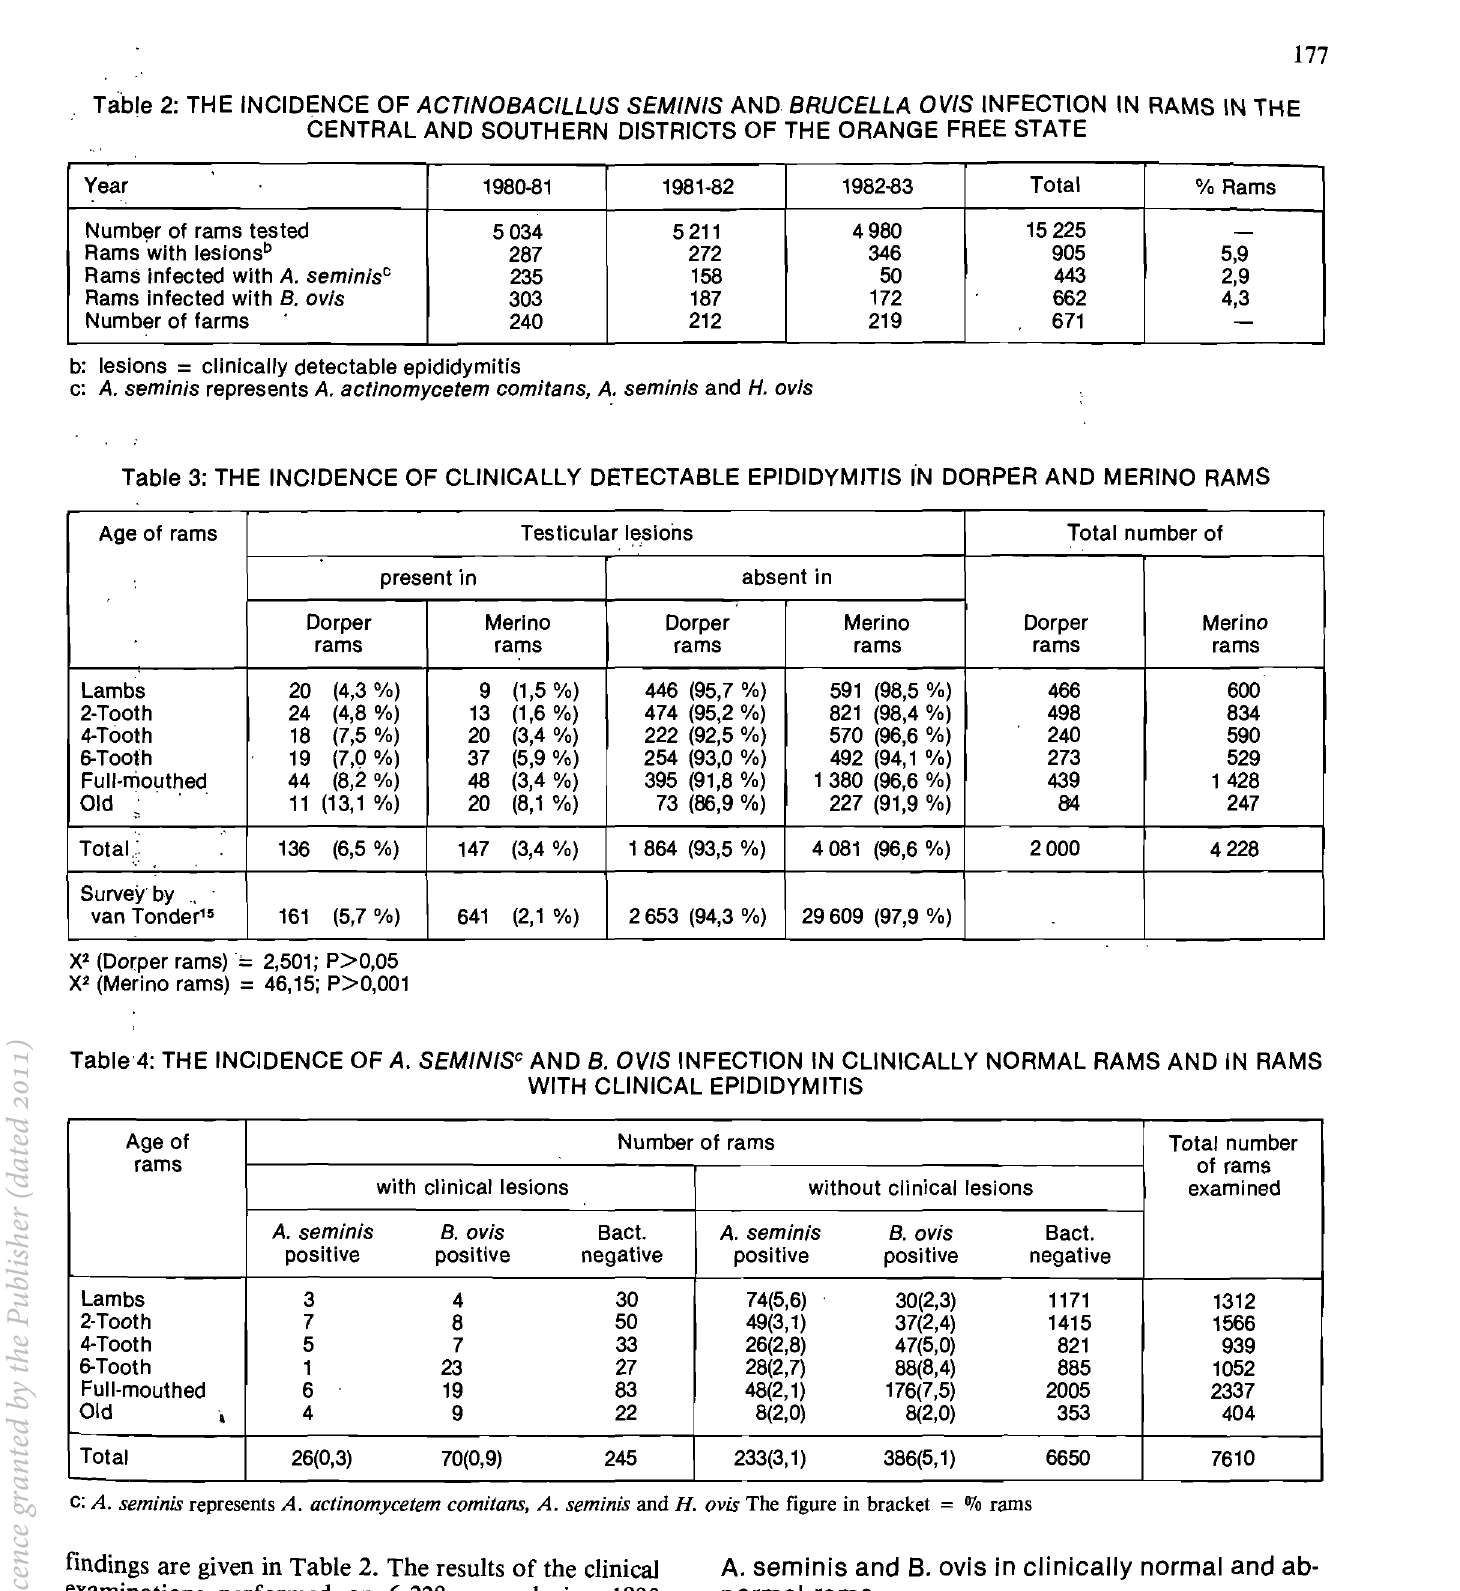
Table 2: THE INCIDENCE OF ACTINOBACILLUS SEMINIS AND BRUCELLA OVIS INFECTION IN RAMS IN THE CENTRAL AND SOUTHERN DISTRICTS OF THE ORANGE FREE STATE